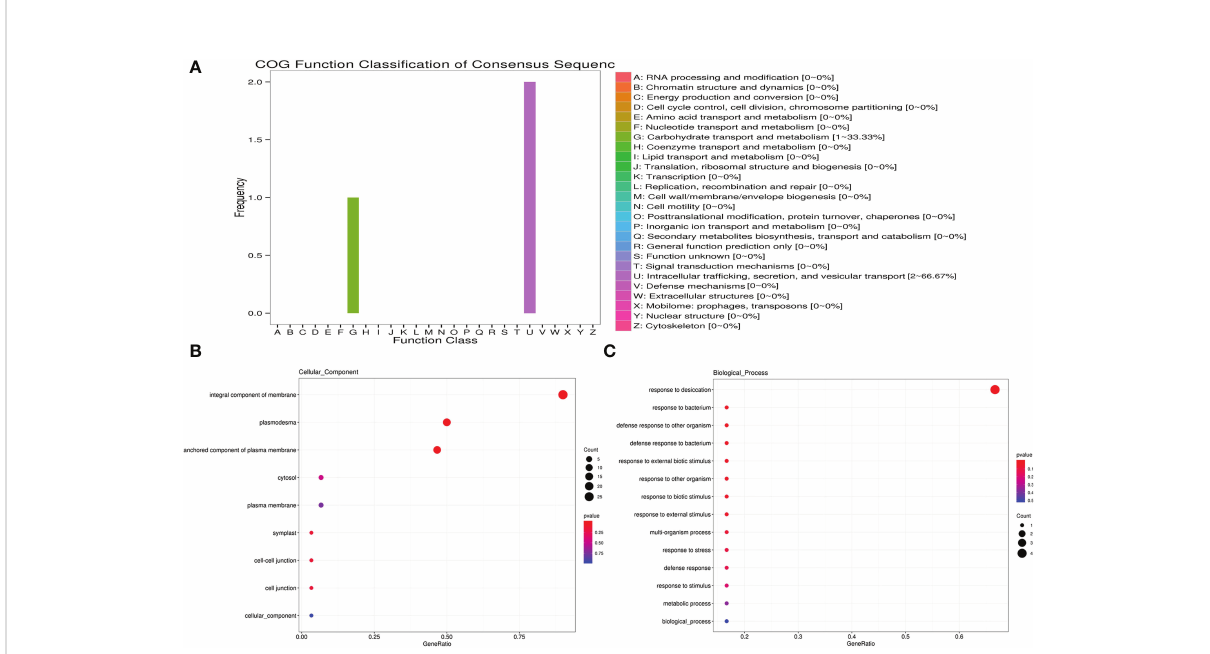
FIGURE 11 COG, GO-BP, and GO-CC enrichment analysis of up-regulated MsLEA_2 genes. (A) Cluster of Orthologous Groups of proteins (COG) analysis of up-regulated MsLEA_2 genes. (B) GO Cellular Component (GO-CC) analysis of up-regulated MsLEA_2 genes. (C) GO Biological Process (GO- BP) analysis of up-regulated MsLEA_2